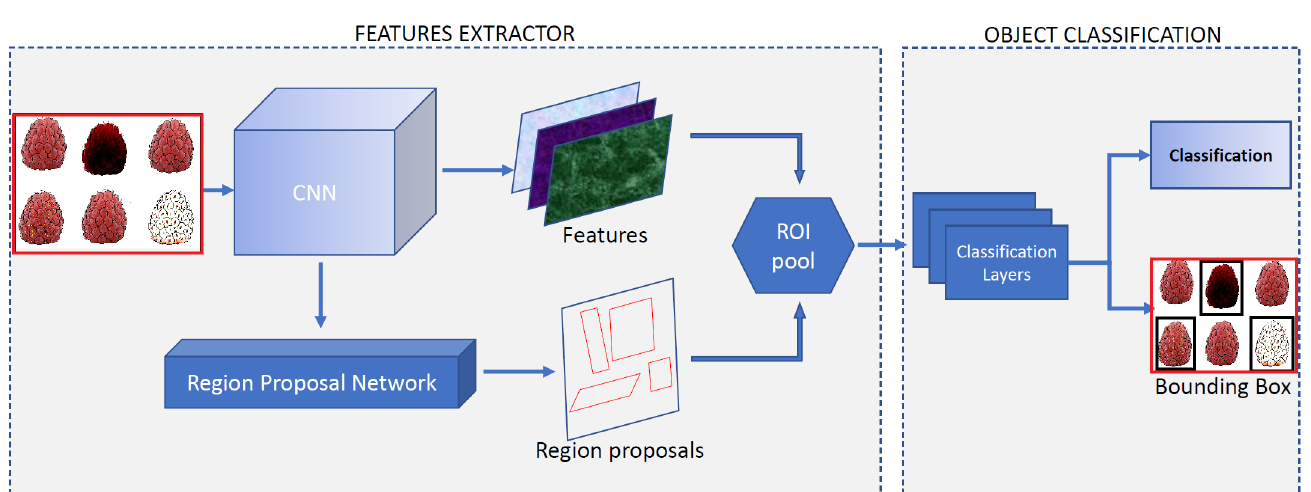
Figure 7. Object detection using the Faster R-CNN process. The ROI pool consists of the features and the proposal regions to be classified in the next